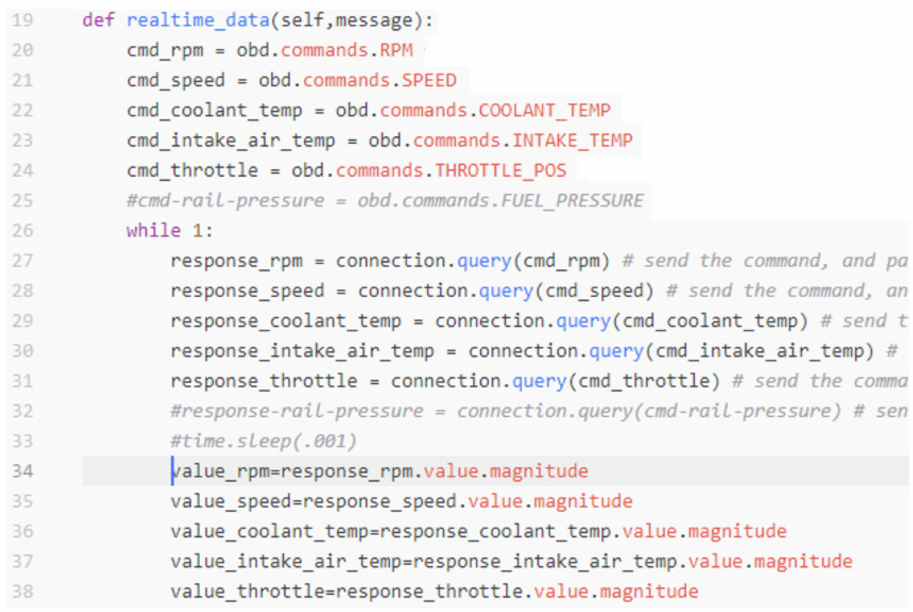
Figure 13. Part of real-time designed reading function in